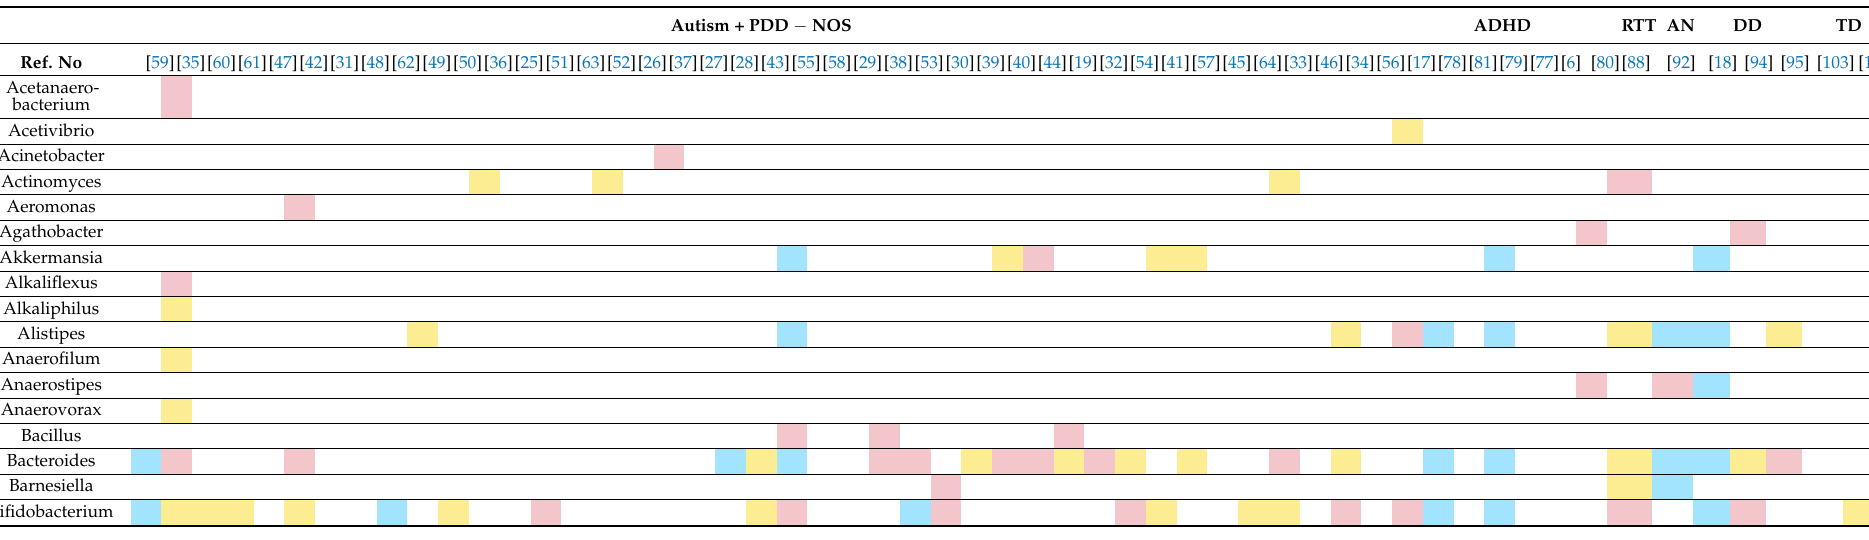
Table 3. Bacterial composition differences in children and adolescents with psychiatric disorders—genus